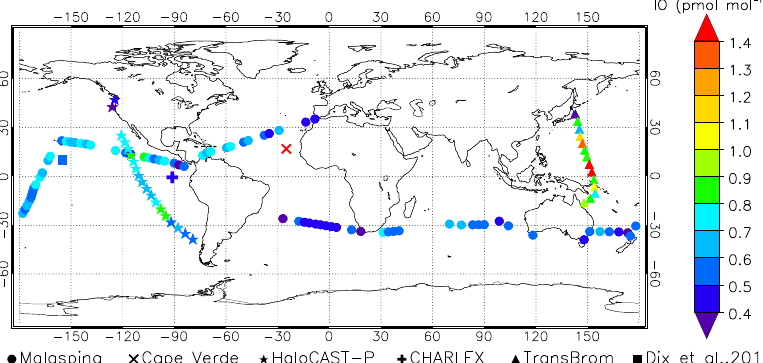
Figure 4. Iodine oxide observations in the global marine boundary layer. IO mixing ratios (in pmolmol − 1 ) are shown for five different field campaigns: Malaspina (this work), CHARLEX (Gómez Martín et al., 2013a), TransBrom (Großmann et al., 2013), HaloCAST-P (Mahajan et al., 2012) and Cape Verde (Read et al., 2008; Mahajan et al., 2010), as well as also for the MBL measurements reported by Dix et al. (2013) during one research flight. For the three ship campaigns (Malaspina, HaloCAST-P and TransBrom) daytime averaged values are shown. For the long-term measurements on the Galapagos and the Cape Verde Islands (referred to as CHARLEX and Cape Verde respectively), the mean daytime IO values observed throughout the campaigns are